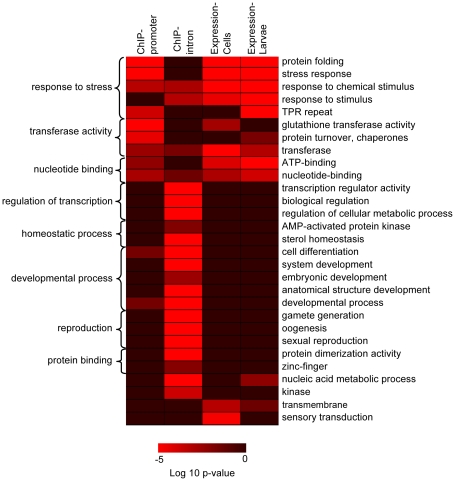
Heat map summary of select categories from DAVID functional enrichment analysis.Genes that were associated with HSF-binding sites in either the promoter or intron regions (column 1 and 2 respectively) and genes that were differentially regulated by HS treatment in either Kc cells or 3rd instar larvae (columns 3 and 4 respectively) were analyzed for functional enrichment. The Functional Annotation Chart tool was used to obtain the p-values describing the probability that a functional term is enriched among genes in the groups examined by random chance, and the Functional Annotation Clustering tool was used to group similar annotation terms. Lower p-values indicating enrichment for the term on the right of the chart are colored in red, while p -values above 0.1 are indicated in maroon. Groups of similar annotation terms are indicated on the left of the chart.